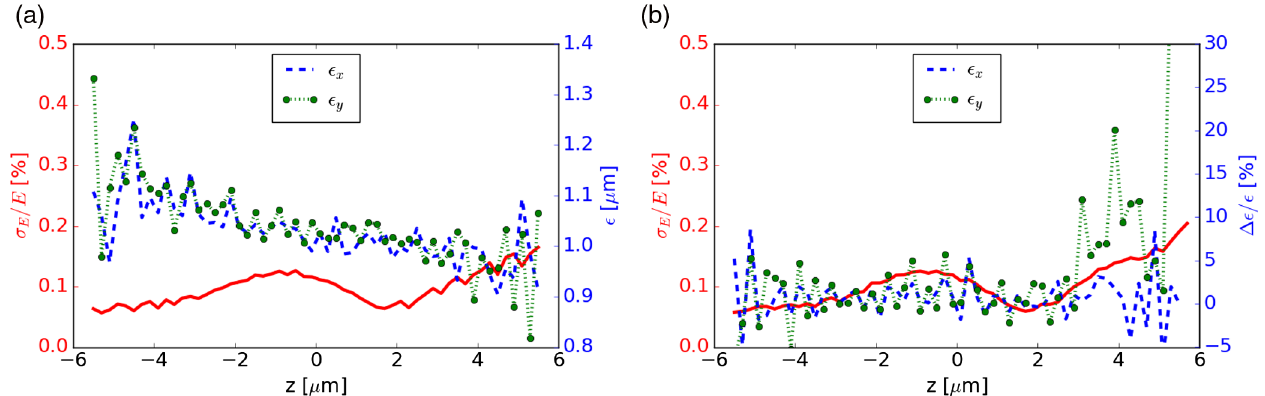
FIG. 10. Initial (a) and final (b) energy spread (red solid line) and horizontal (vertical) normalized slice emittance [blue (green) dashed line] in each 0 . 2 μ m long